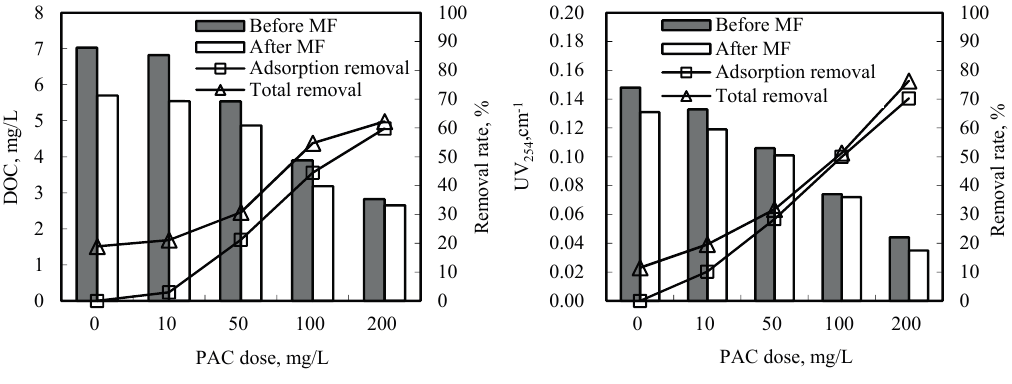
Figure 2. Efficiencies of DOC and ultraviolet absorbance at 254 nm (UV 254 ) by powder activated carbon (PAC)/MF